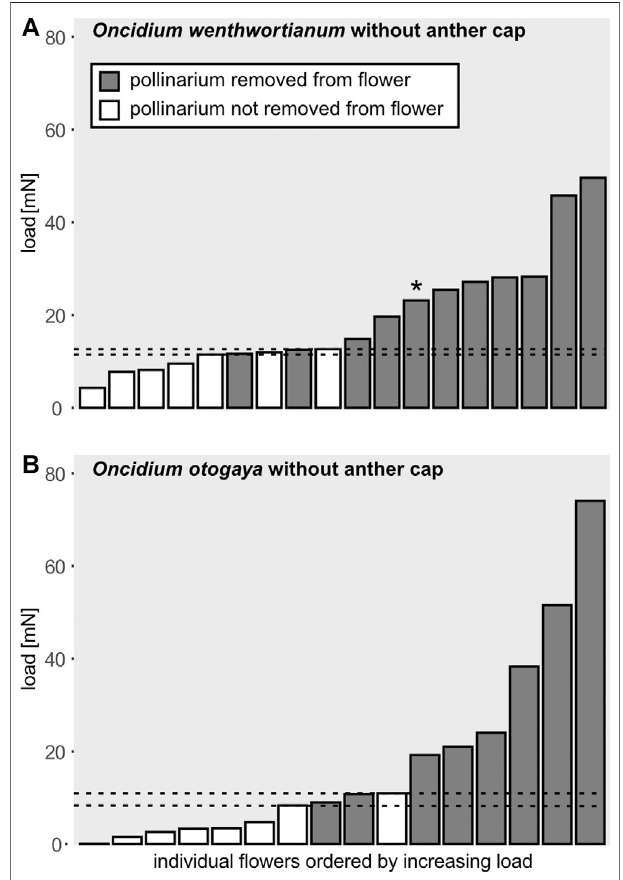
FIGURE 6 | Applied load and related success of removal of the pollinarium in (A) Oncidium wentworthianum and (B) O. otogaya for fl owers without anther cap. The gray bars show the applied load that leads to successful pull-off of the pollinarium from the fl ower. The white bars correspond to the load that was not suf fi cient to separate the pollinarium from the fl ower. The dotted lines indicate the threshold of the load suf fi cient to overcome the initial attachment of the pollinarium to the fl ower. When the applied load was higher than the upper threshold, the pollinarium could be removedfromthe fl owerinallattempts.Whentheappliedloadwaslowerthan the lower threshold, the pollinarium could be removed from the fl ower in no attempt. (*This pollinarium was successfully and completely separated; however, after a short distance of pull-off it got stuck and detached from the glass rod. The pollinarium was thus rated as successfully removed from the fl